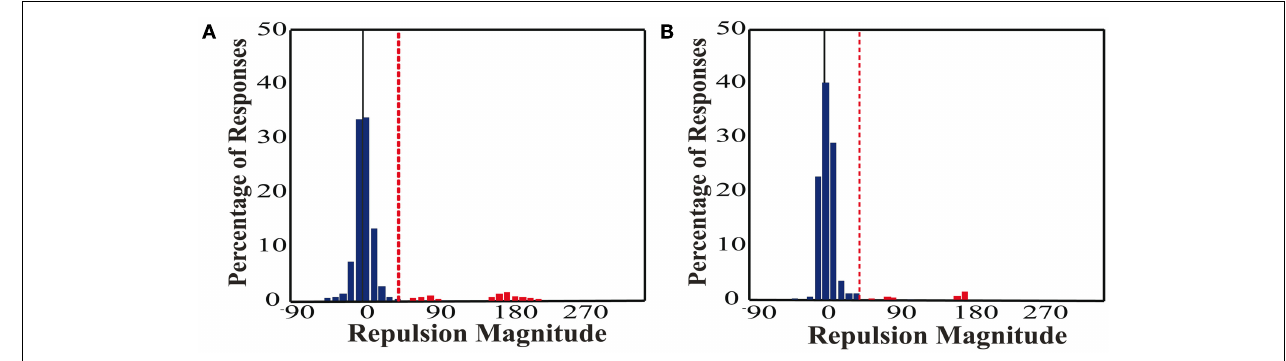
line. Responses outside of this range are indicated in red and were classified as errors. Note the majority of responses fall within the correct range.The errors are distributed around 90˚ and 180˚, consistent with guessing the remaining cardinal